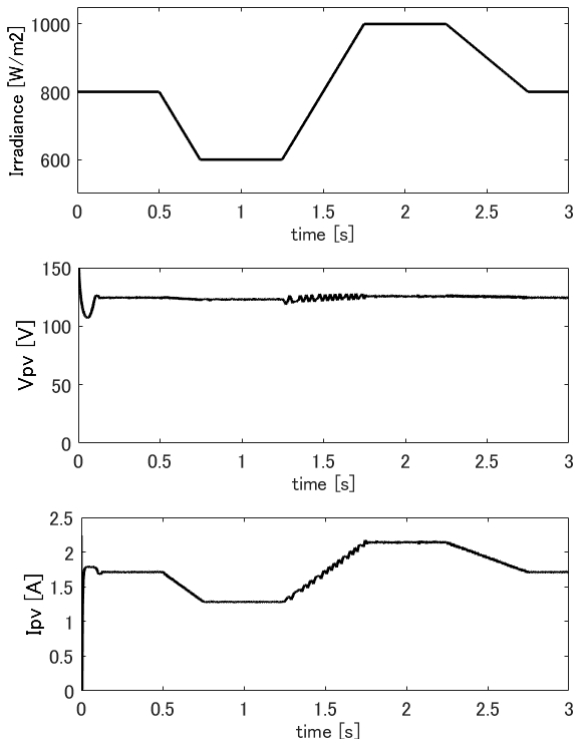
Figure 16. Responses of the proposed MPPT control with the varying irradiance.